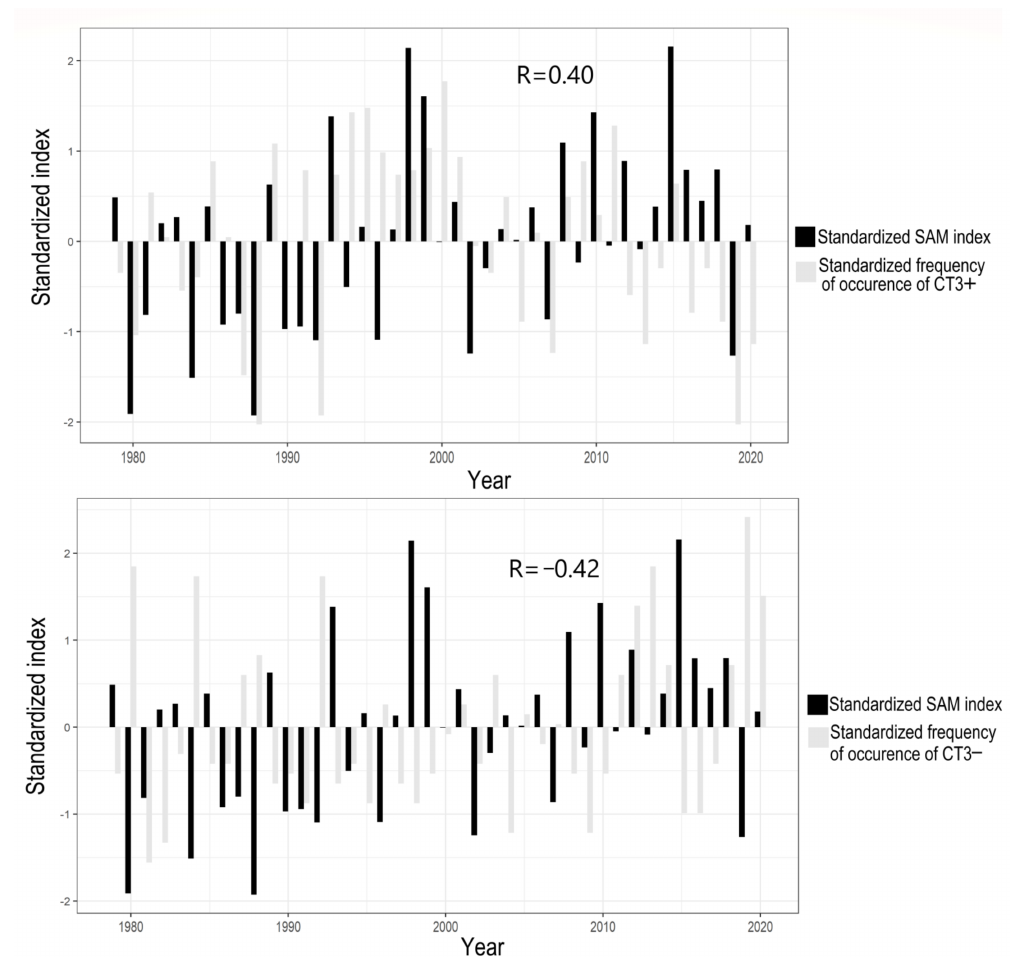
Figure 9. Relationship between the annual frequency of occurrence of CT3+ ( top ) and CT3 − ( bottom ) and the SAM for the 1979–2020 period. The correlation coefficient between the indices is written in the